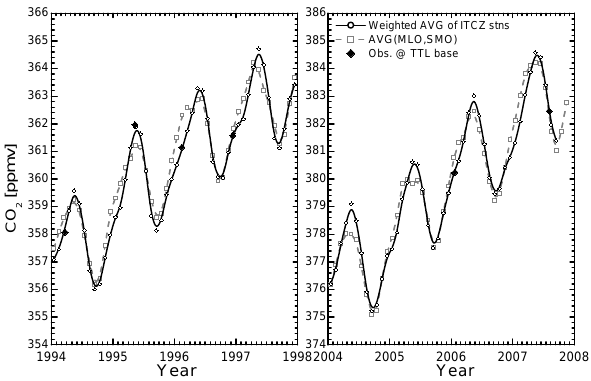
Fig. 2. Boundary condition for CO 2 entering the TTL. Solid curve is the weighted average of surface data from NOAA ESRL stations located in the ITCZ (Conway et al., 1994). The previous CO 2 index defined as average data for CO 2 at Mauna Loa (MLO) and Samoa (SMO) is plotted as gray dashed curve. Filled diamonds repre- sent data obtained near 360K ( ∼ 15km) during ASHOE, STRAT, CRAVE, and TC4: Airborne Southern Hemisphere Experiment (ASHOE) from March to November 1994; Stratospheric Tracers of Atmospheric Transport (STRAT) from May 1995, October to November 1995, January to February 1996, July to August 1996, September 1996, December 1996; CR-AVE in January to February 2006; TC4 in August